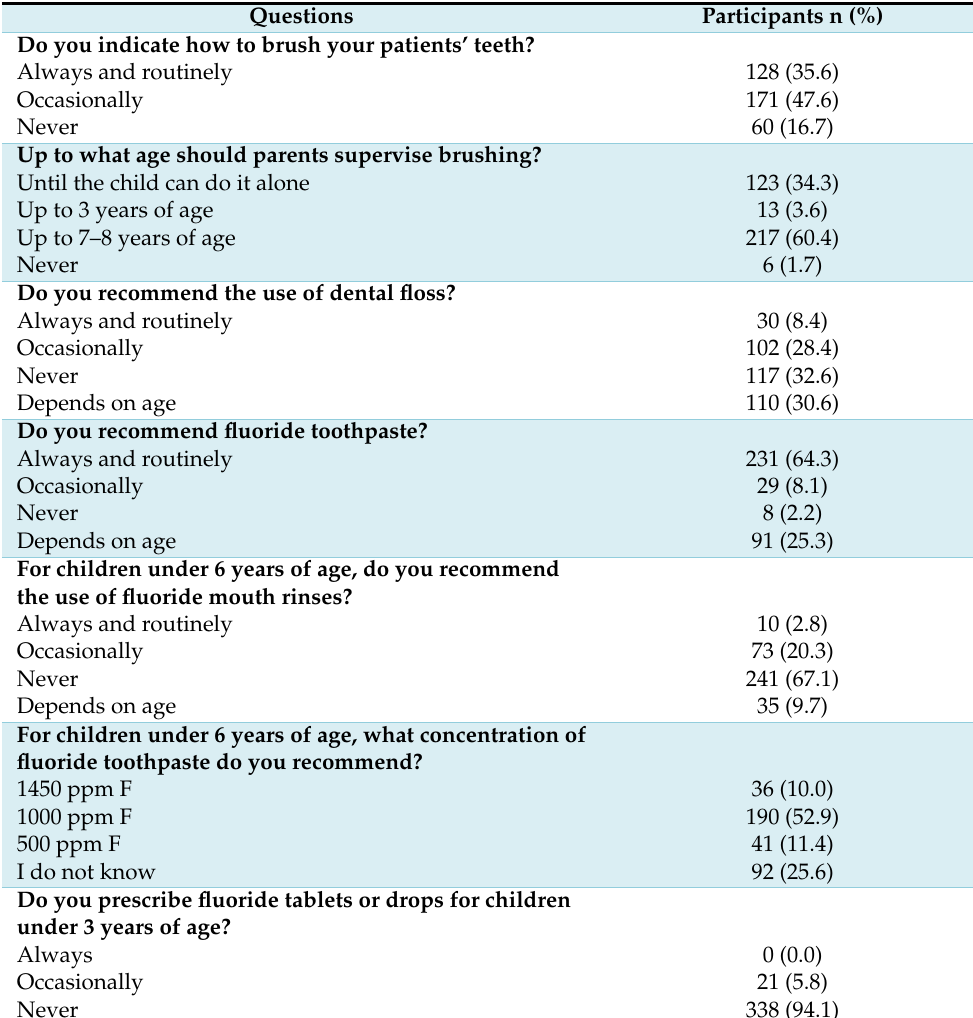
Table 4. Oral hygiene and preventive